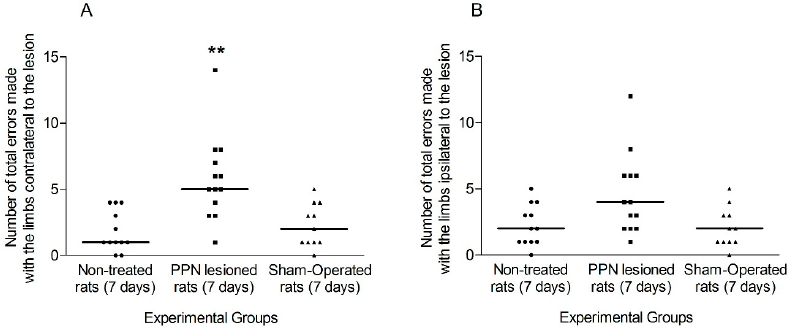
Figure 5. Comparison of the total faults made by the limbs of each side during the execution of Grid Test seven days after pedunculopontine nucleus lesion. ( A ) Faults exhibited by the contralateral limbs (H (2, 38) = 12.34 p < 0.01). ( B ) Faults corresponding to ipsilateral limbs (H (2,38) = 5.00 p > 0.05). Kruskal–Wallis test. ** p < 0.01. The points represent the number of errors of each experimental subject. The horizontal lines represent the median of each sample.